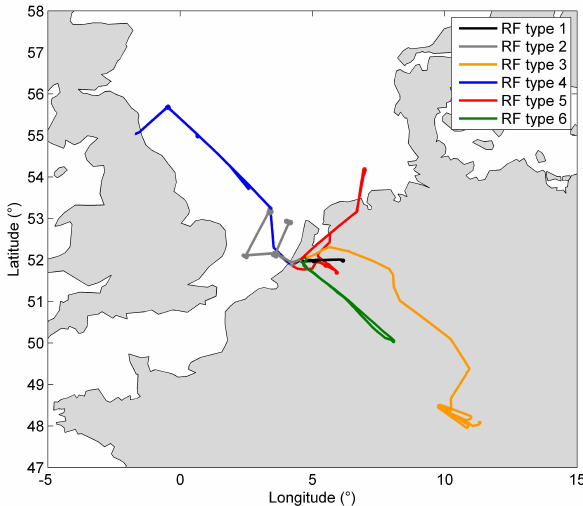
Fig. 1. Different types of research flight (RF) plans performed dur- ing the EUCAARI intensive observation campaign in May